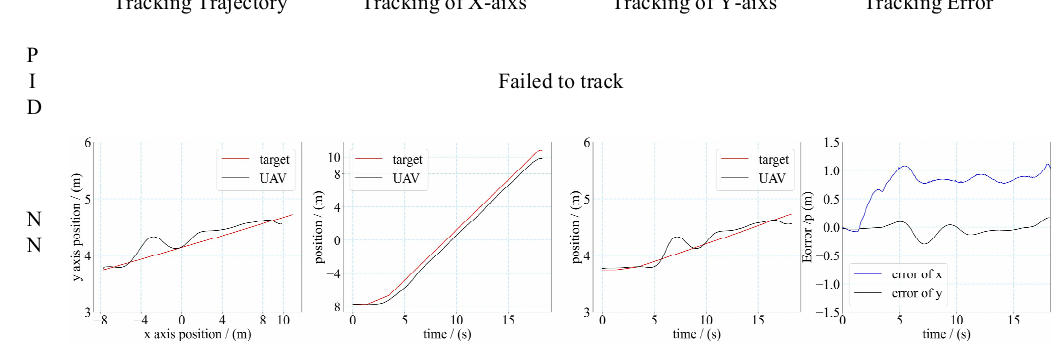
Figure 14. Trajectory and tracking error of UAV tracking target. (Target’s velocity is 1.2 m/s). The performance of the controller was evaluated by the mean tracking error (MTE) of the X -axis and Y -axis, and the steady state error (SSE) during the tracking tests. The mean tracking error was calculated as Equation (14).